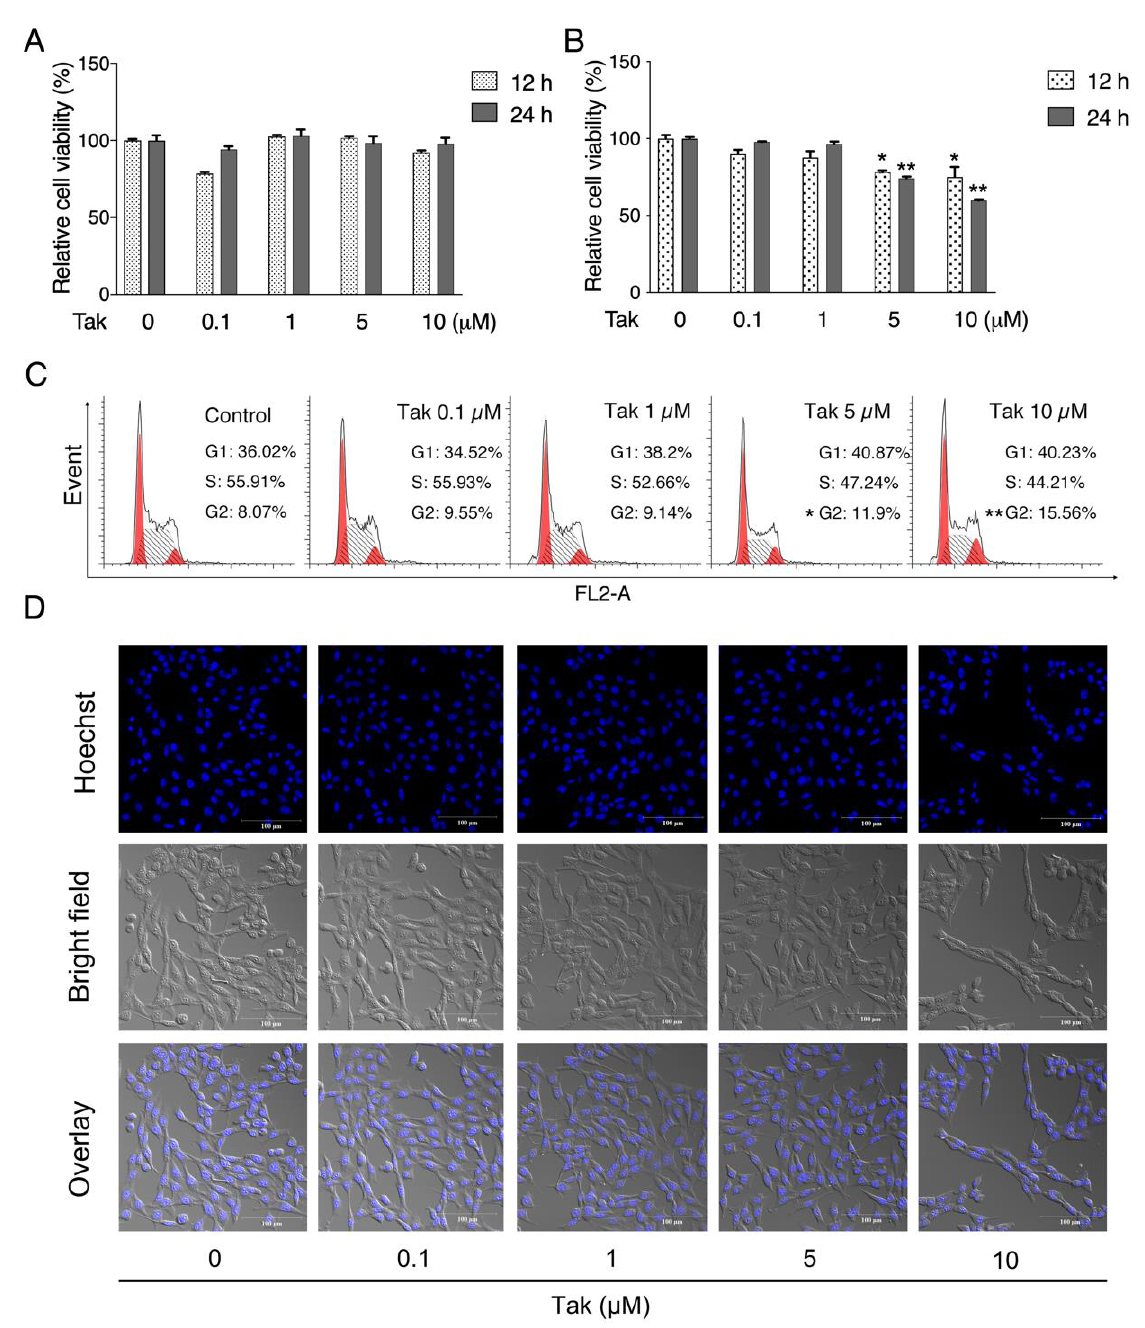
Figure 1. The effect of Tak on cell viability. ( A ) HT22 cells were treated with Tak at concentrations of 0.1, 1, 5, and 10 µ M for 12 and 24 h, and cell viability was analyzed. ( B ) SH-SY5Y cells were treated with Tak at concentrations of 0, 0.1, 1, 5, and 10 µ M for 12 and 24 h, and cell viability was analyzed. ( C ) Flow cytometry analysis of the cell cycle in SH-SY5Y cells treated with Tak for 12 h. ( D ) Hoechst staining of SH-SY5Y cells treated with Tak for 12 h. The values are presented as the mean ± S.E.M. from at least three independent experiments. * p < 0.05 and ** p < 0.01 vs. the control.